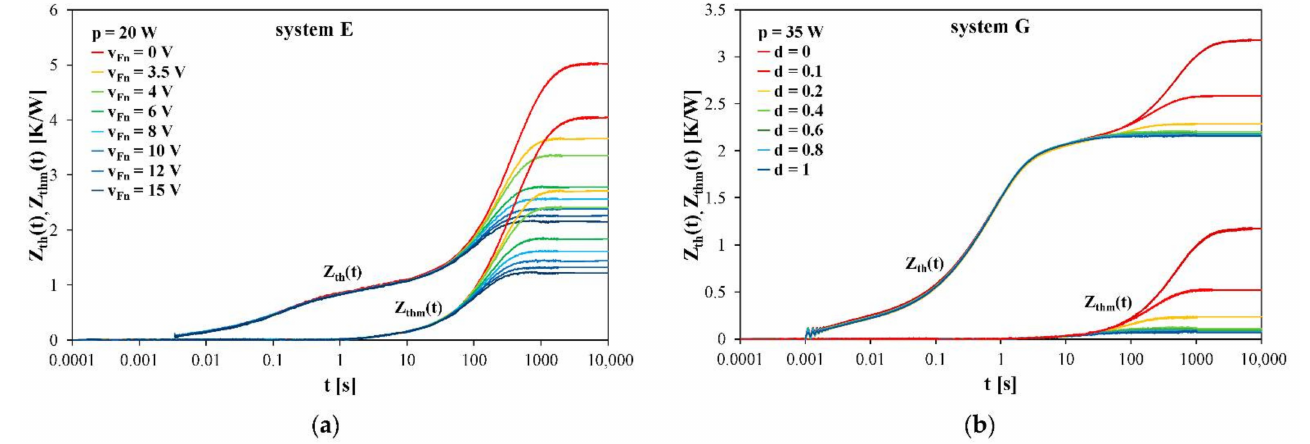
Figure 13. Self- and transfer-transient thermal impedances of the investigated MOSFETs with the cooling system ( a ) E and ( b )